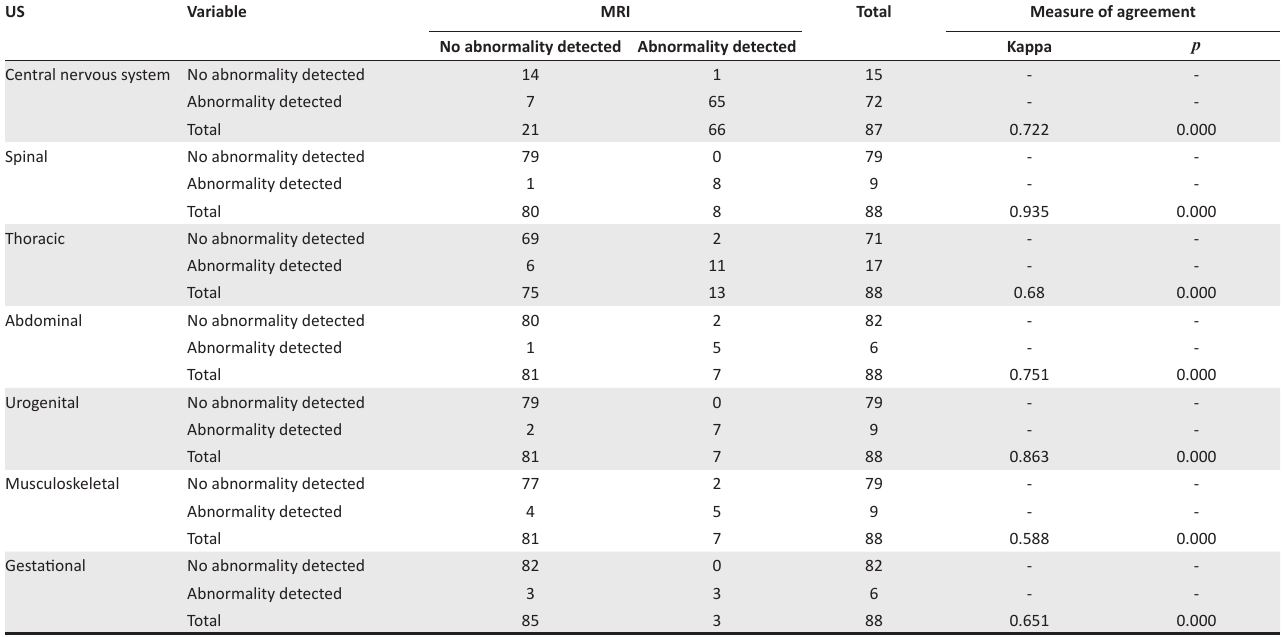
TABLE 6: Cohen’s Kappa scores per organ system.